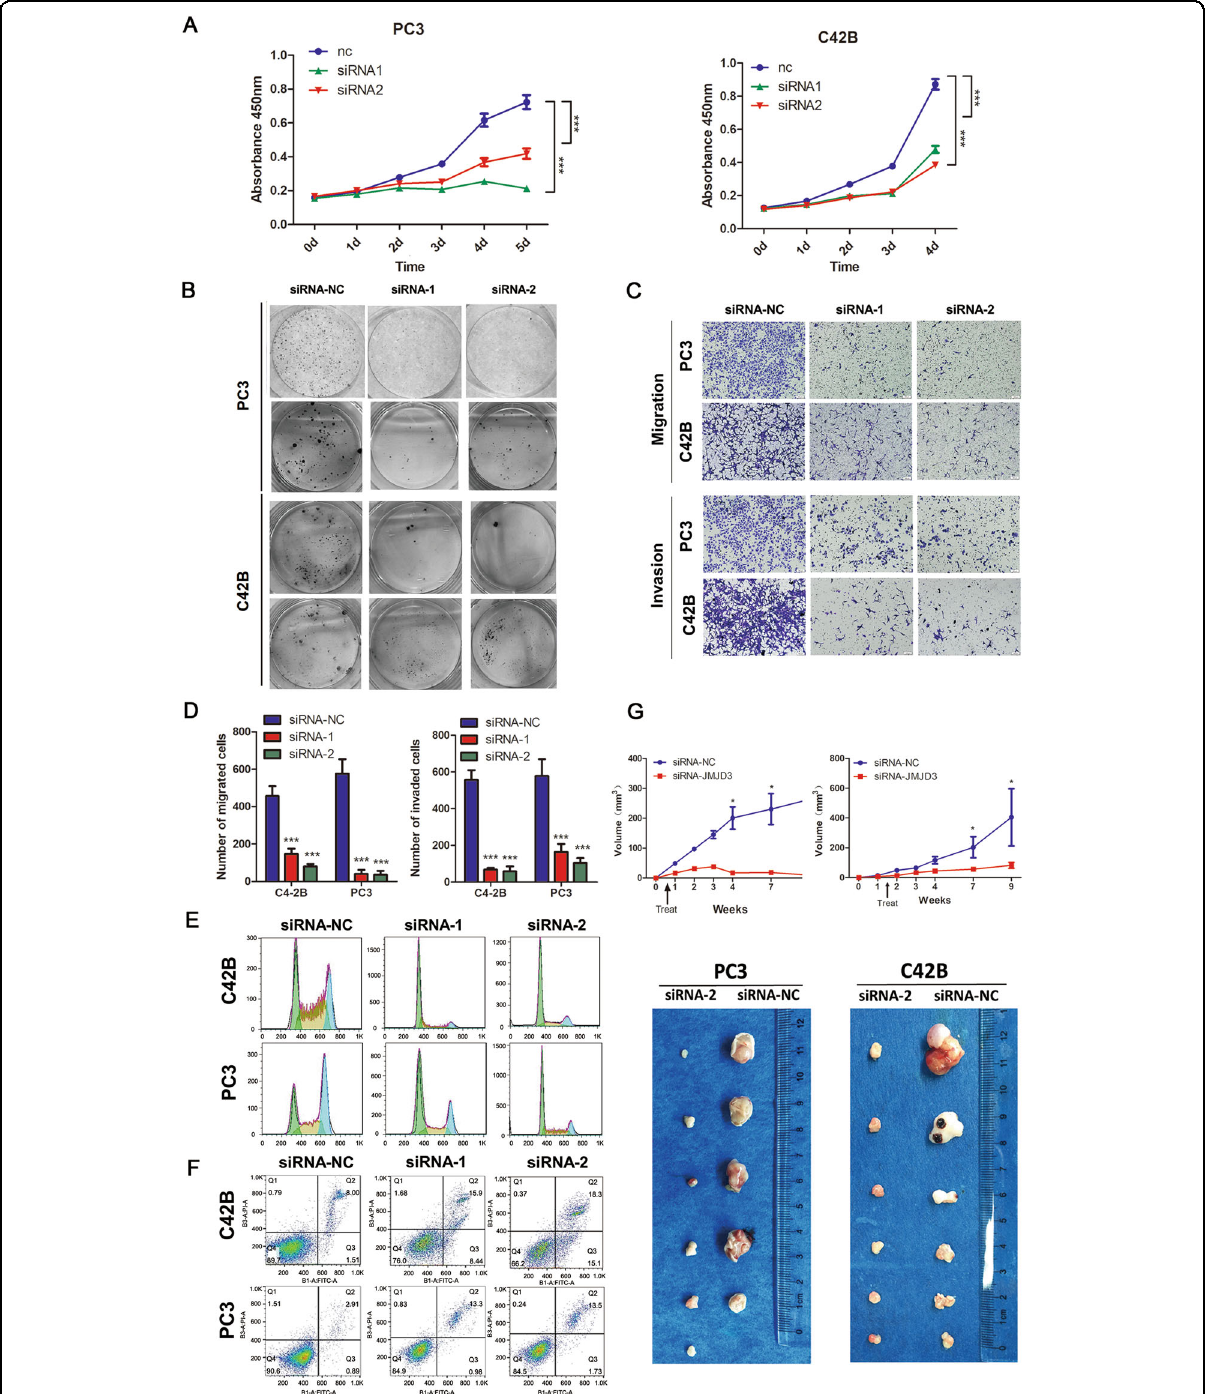
Fig. 2 Cellular function and in vivo experiments. A The proliferation abilities of PC3 and C42B cells transfected with KDM6B siRNA are shown. Error bars means SD, N = 3 independent repeats. B The colony formation abilities of PC3 and C42B cells transfected with KDM6B siRNA are shown. C , D The knockdown of KDM6B by siRNA suppressed the migration and invasion abilities of PC3 and C42B cells. Error bars means SD, n = 3 independent repeats. E A cell cycle analysis of PC3 and C42B cells transfected with KDM6B siRNA was performed. F An apoptosis analysis of PC3 and C42B cells transfected with KDM6B siRNA was performed. G Nude mice were subcutaneously xenografted with PC3 and C42B cells, and were treated intratumorally with scrambled or KDM6B siRNA. The tumor growth curve and representative tumor images are shown (Note: AR, androgen receptor; TF, transcription factor; DHT, dihydrotestosterone; MDV3100, enzalutamide; DMSO, dimethylsulfoxide; WT, wild type; MUT, mutation.) Error bars mean SD, six mice in each group with one lost in PC3 cell line + negative control siRNA (* p < 0.05, *** p <